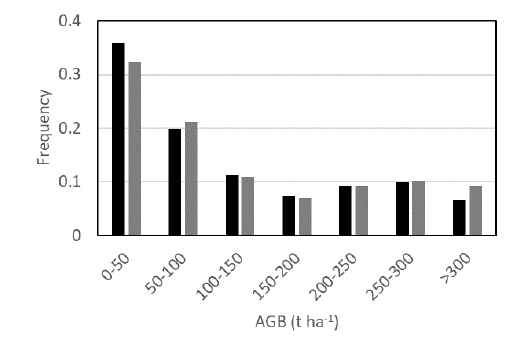
Figure 3. Histograms of AGB estimates from NFI plots using Chave et al. (2014) and Alvarez et al. (2012) models The results of the Jackknife analyses based on root mean square error (RMSE), bias, and coefficient of determination (R 2 ) indicated that the combination of ALOS-2 PALSAR-2 and Landsat variables showed the best balance between the lowest possible bias and RMSE, and the highest possible R 2 (Figure 4)